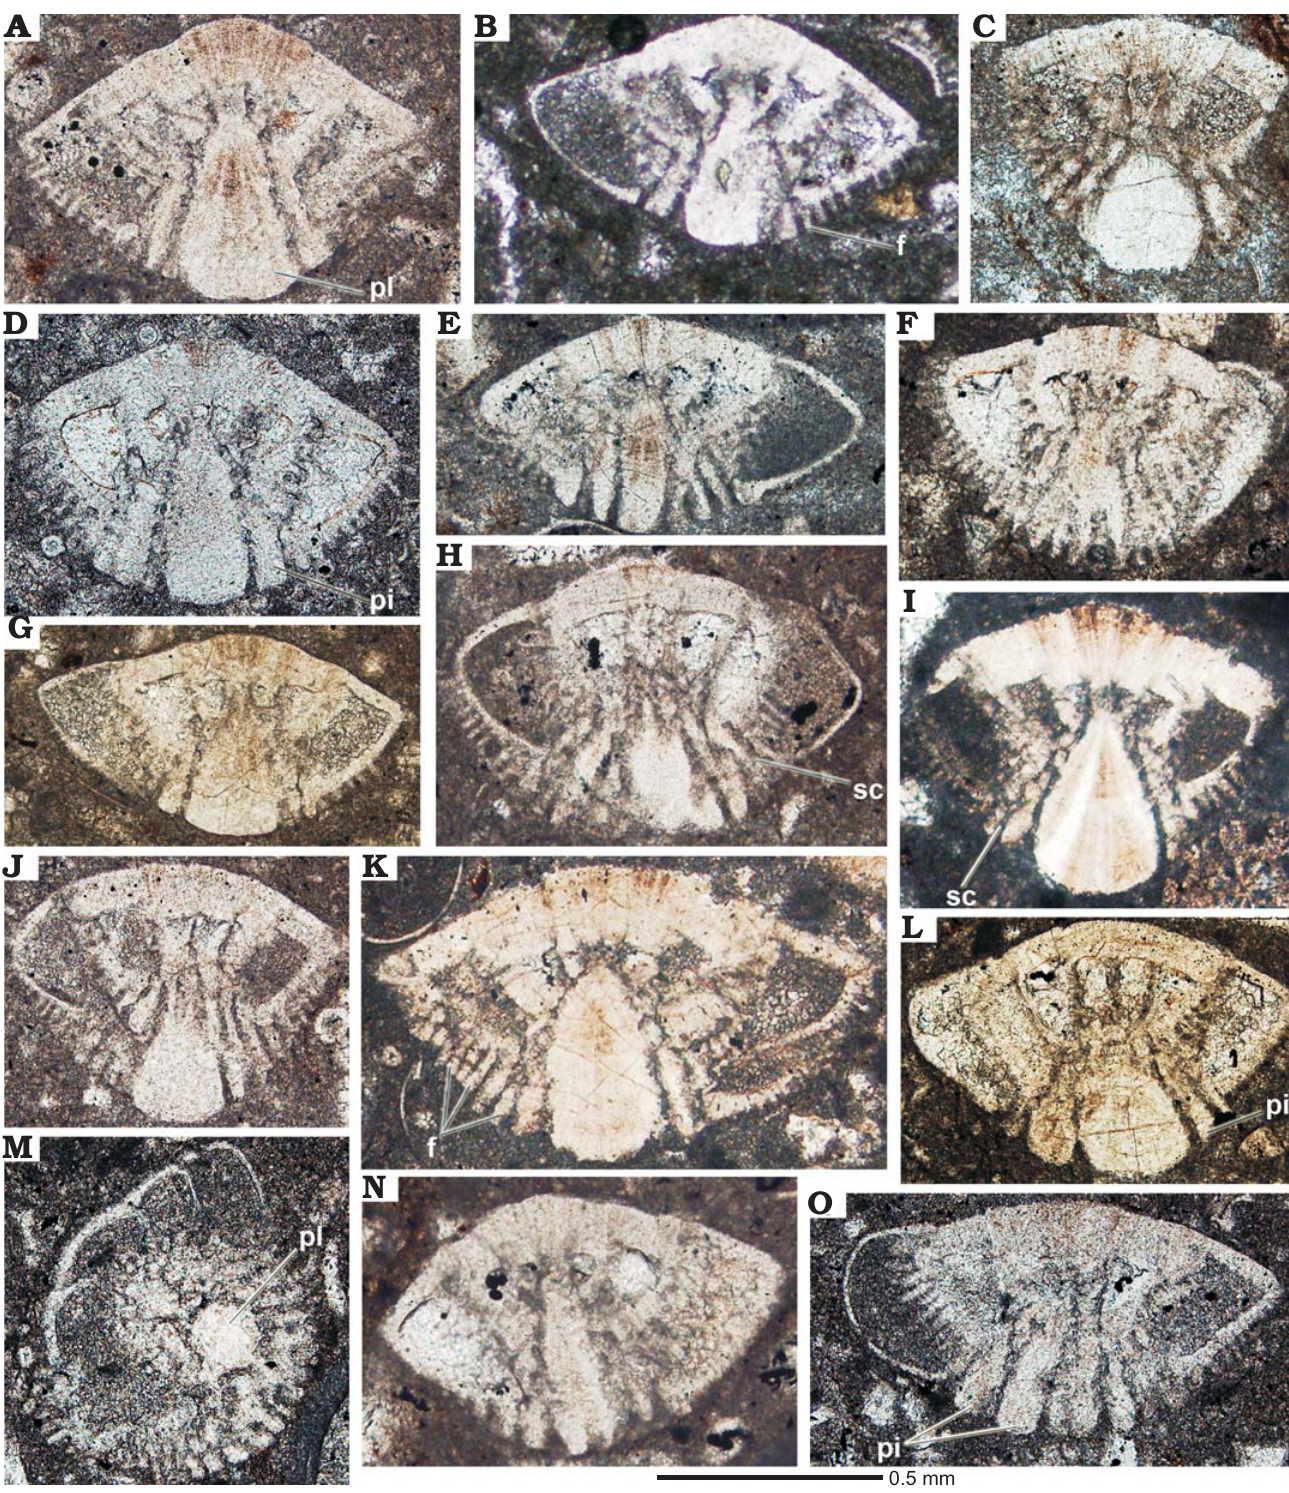
Fig. 4. Rotaliid foraminifer Elazigina siderea sp. nov. (A, holotype) from the Maastrichtian of Rod Abad section, Iran; axial (A, B, D, I, K), subaxial (E–H, J, L, N, O), oblique (C), and transversal-basal (M) sections. A – D , G , J – O . APNU-Tf12 (type-level). F , H , N . APNU-Tf11. E . APNU-Tf4. Abbreviations: f, feathers; pi, piles; pl, umbilical plug; sc, spiral